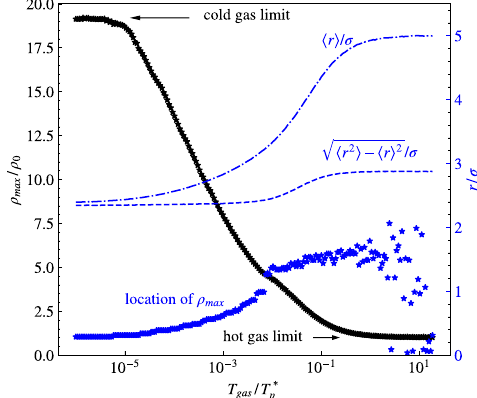
FIG. 19. Variation of the radial density distribution of EDM molecules with temperature T=T (cid:3) p . Shown are the density enhancement due to the pinch in the beam field (black markers, left axis), the radial location of the maximum (blue markers, right axis), the average radial position of molecules (dash-dotted blue line), and the rms value of the radial position (dashed blue